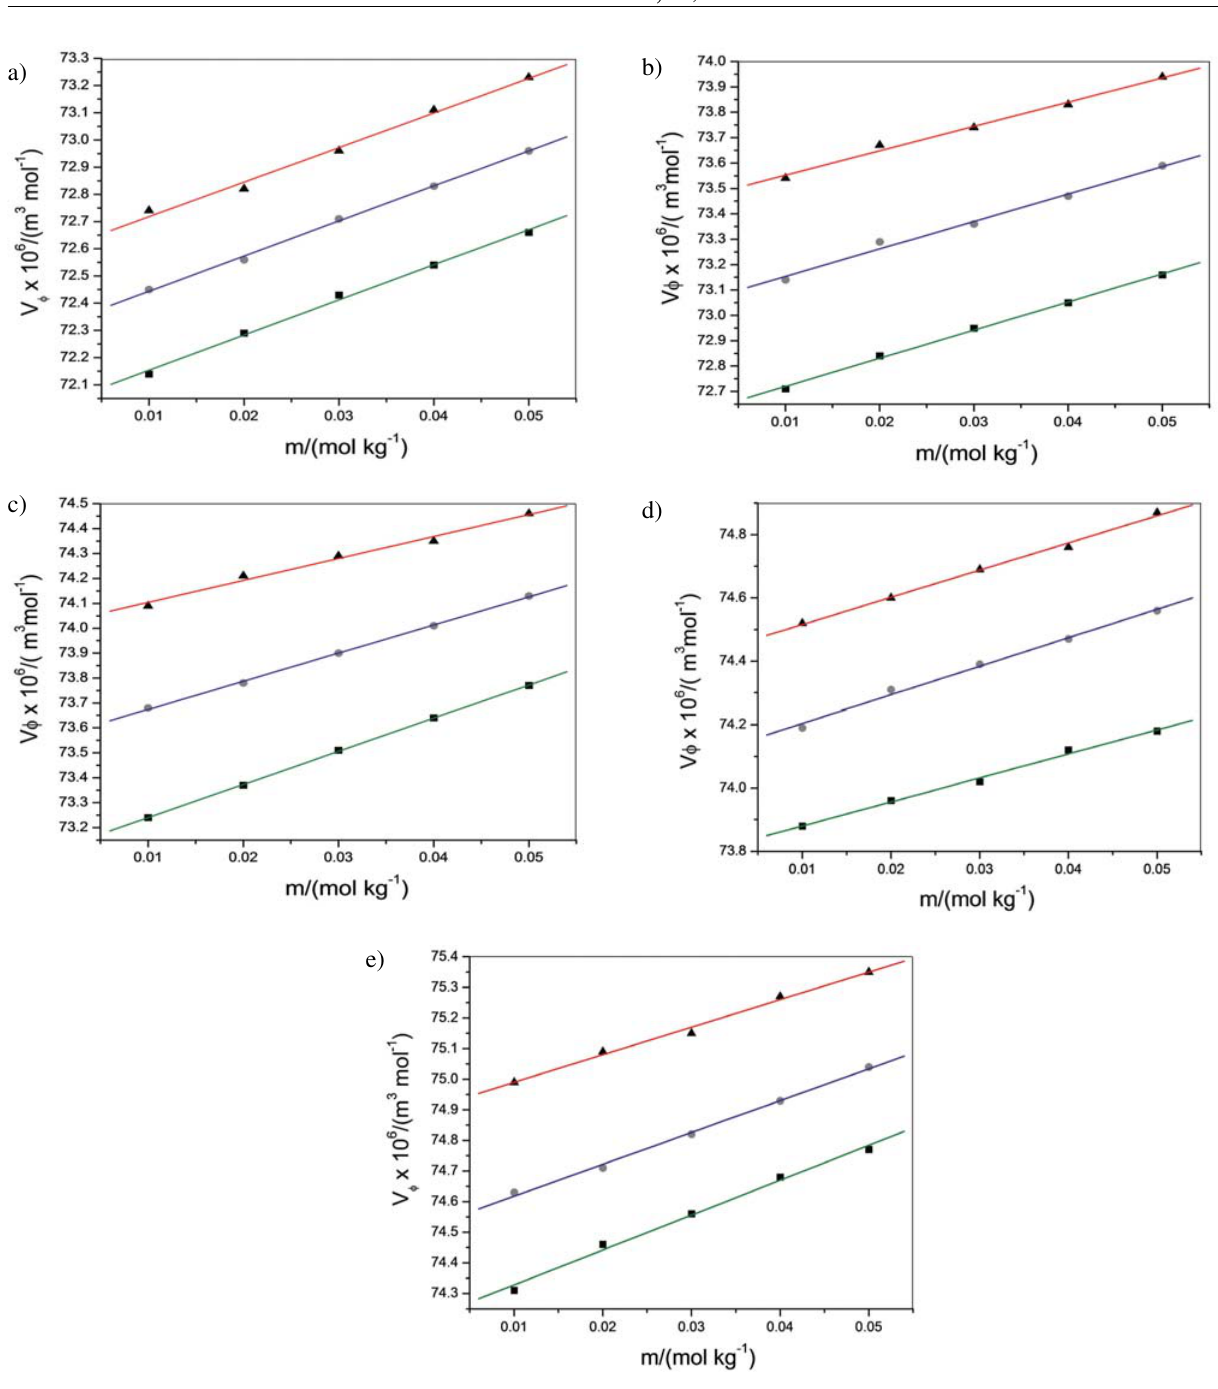
Figure 1. Variation of apparent molar volume versus molality of Asp in aqueous and aqueous + PD solutions: (a) water, (b) 5% PD, (c) 10% PD, (d) 15% PD and (e) 20% PD at temperatures, T /K = 298.15 ( (cid:2) ); 303.15 ( (cid:3) ); 308.15 ( (cid:2)